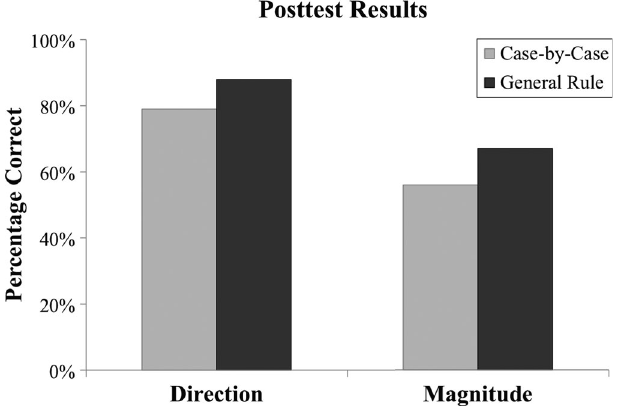
FIG. 8. Correctness on the direction and magnitude posttest questions. On both the direction and magnitude questions, GR performed 10% better than CC.